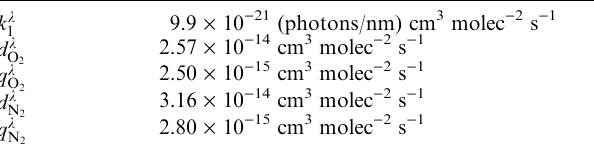
Table 1. The required NO+O rate parameters for k = 553 nm k k